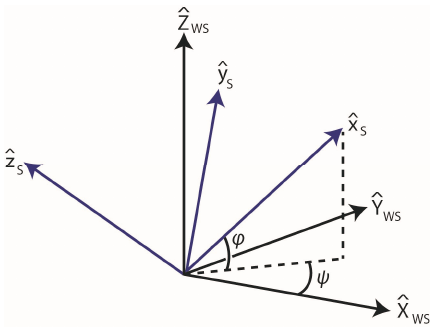
Figure 2. The orientation of the shank IMU frame, (cid:1832) (cid:3020) , (blue) relative to the shank world frame, (cid:1832) (cid:3024)(cid:3020) , (black). The orientation is defined by the illustrated yaw (cid:2032) and vertical (cid:2030) angular components. The F WS , (black). The orientation is defined by the illustrated yaw ψ and vertical ϕ angular components. horizontal dotted line is the projection of (cid:1876)(cid:3548) (cid:3020) onto the (cid:1850)(cid:3552) (cid:3024)(cid:3020) – (cid:1851)(cid:3552) (cid:3024)(cid:3020) plane and the vertical dotted line is The horizontal dotted line is the projection of ˆ x S onto the ˆ X WS – ˆ Y WS plane and the vertical dotted line the projection onto the vertical direction. is the projection onto the vertical direction.